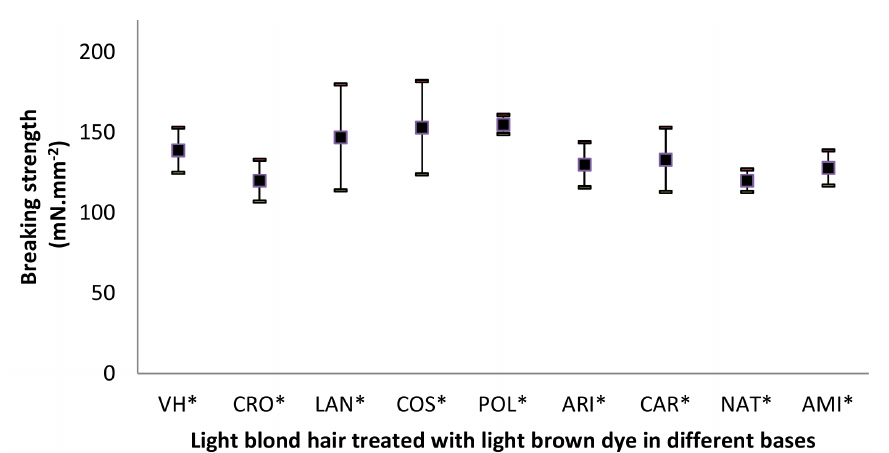
FIGURE 2 - Breaking strength for Caucasian dark brown virgin hair and samples treated with light blond oxidative hair dyes. Results categorized with equal symbols (*) mean they didn’t present as statistically and significantly different, for α = 5, p < 0.05, n = 5. VH: Virgin Hair; CRO: Cetearyl Alcohol (and) Dicetyl Phosphate (and) Ceteth-10 Phosphate/ Crodafos TM CES; LAN: Cetearyl Alcohol (and) Sodium Lauryl Sulfate (and) Sodium Cetearyl Sulfate /Lanette N TM ; COS: Cetearyl Alcohol (and) Ceteareth-20/ Cosmowax J TM ; POL: Cetearyl Alcohol (and) Polysorbate 60/ Polawax NF TM ; ARI: Ammonium Acryloyldimethyltaurate (and) VP Copolymer/ Aristoflex avc TM ; CAR: Carbomer/ Carbopol TM 980 ; NAT: Hydroxyethylcellulose/ Natrosol TM HHR ; AMI: Sclerotium gum/ Amigel TM .